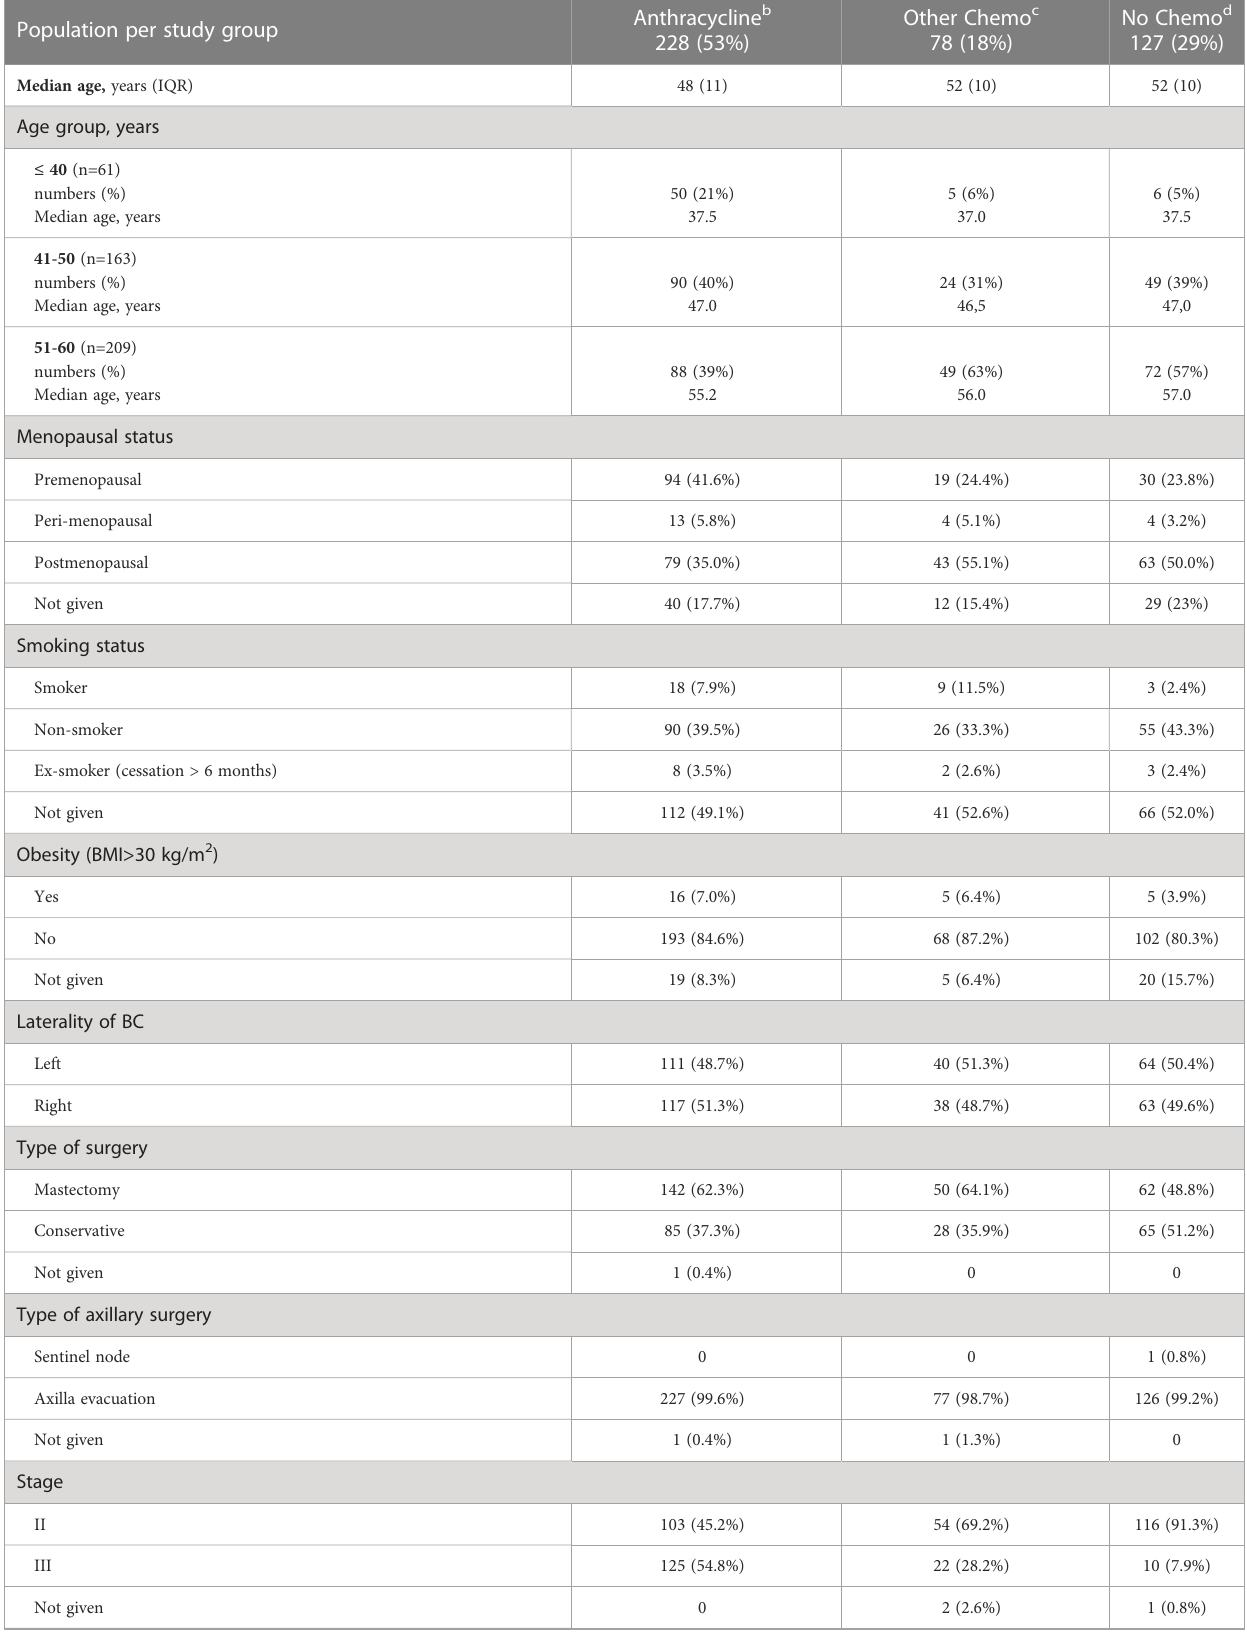
TABLE 1 Demographic and clinical characteristics of 433 patients a with lymph node-positive early breast cancer (BC) at diagnosis in the Southeast Healthcare Region, Sweden, January 1, 1998, to December 31,